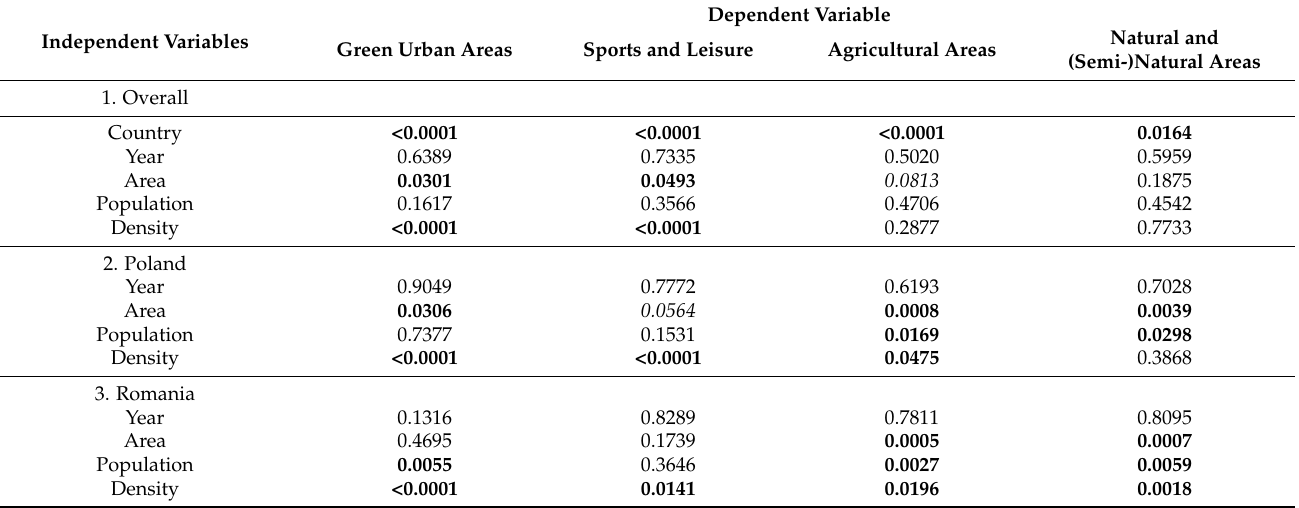
Table 1. Variables influencing the structure of GI categories in Romanian and Polish cities covered by Urban Atlas data. The table displays the p value associated with each relationship, using the following notations: Bold —significant, p ≤ 0.05; Italic —significant, p ≤ 0.1; Regular—not significant, p > 0.1.